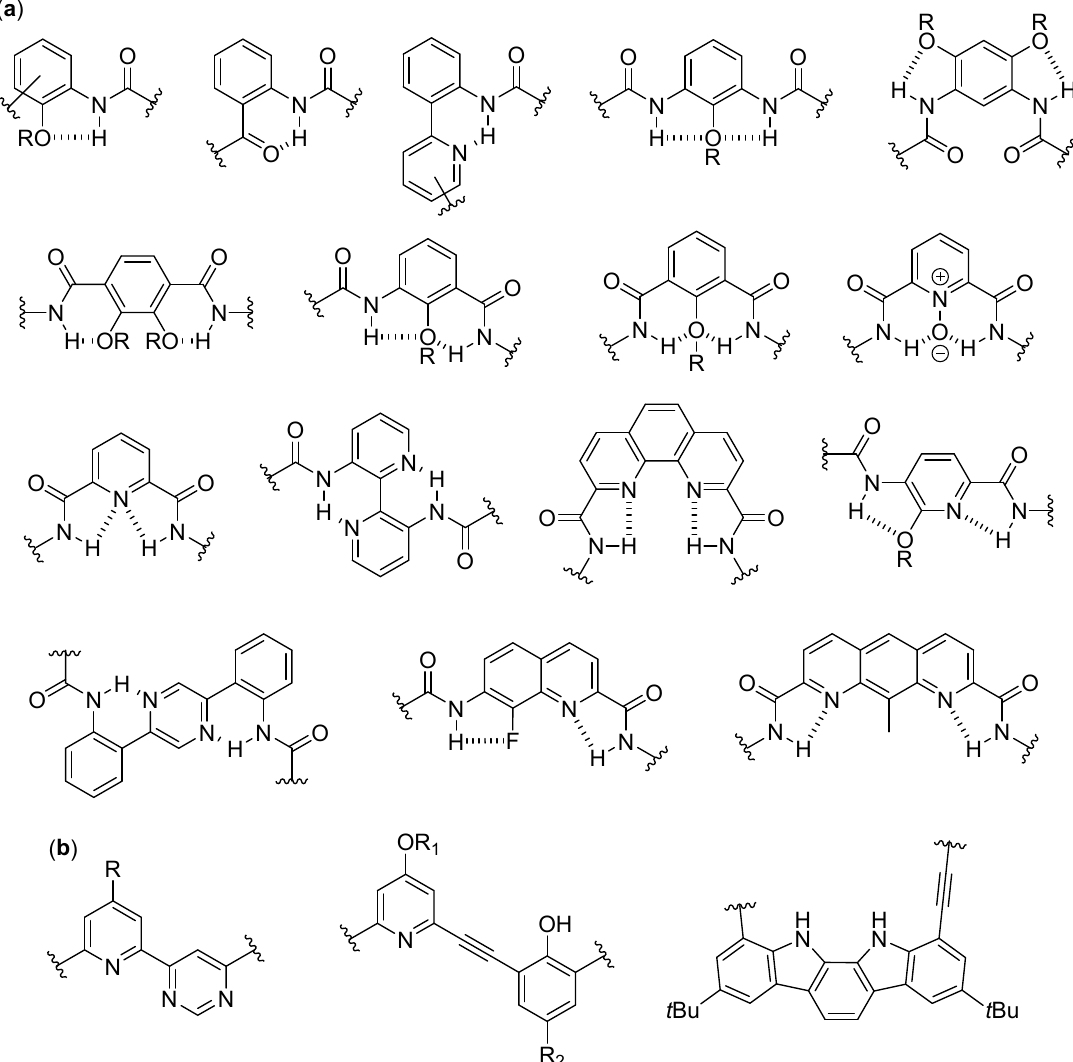
Figure 2. ( a ) Representative monomers for the construction of aromatic amide foldamers and their hydrogen bonding patterns; ( b ) Representative structural motifs for the construction of aromatic foldamers not based on conventional hydrogen bonding (for reviews dealing with the secondary structures of these foldamers, see Refs. [2,6,10–12,18,19]).